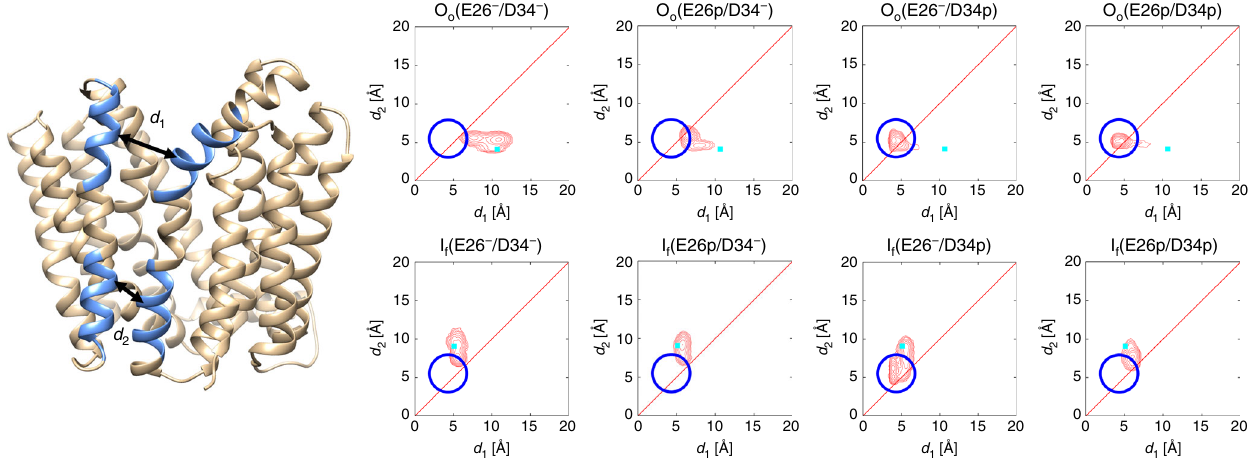
Fig. 5 Conformational distributions of MdfA obtained following MD simulations. Starting from each initial conformation (O o vs. I f ) and Glu26/Asp34 protonation state, the conformational distributions of the MD simulations were calculated as a function of d 1 and d 2 ( d 1 : minimum distance between C α atoms of residues 156 – 165 (TM5) and those of residues 253 – 262 (TM8); d 2 : minimum distance between C α atoms of residues 139 – 148 (TM5) and those of residues 270 – 279 (TM8)). Cyan squares indicate the corresponding distances in the initial conformations (O o : this study; I f PDB 4ZOW), and the blue circles indicate the position of the peak in the plot for O o (E26 − /D34 p